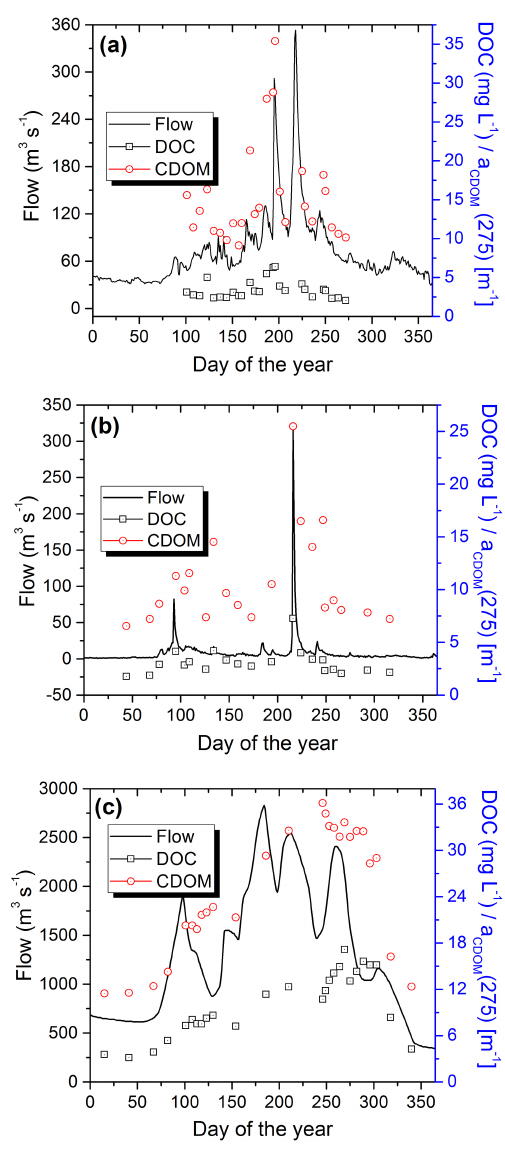
Figure 4. Concurrent flow dynamics for three rivers in Northeast China and the corresponding DOC and CDOM variations in 2015; (a) the Yalu River near Changbai county, (b) the Hunjiang River with DOC and CDOM sampled at Baishan, while the river flow gauge station is near Tonghua, and (c) the Songhua River at